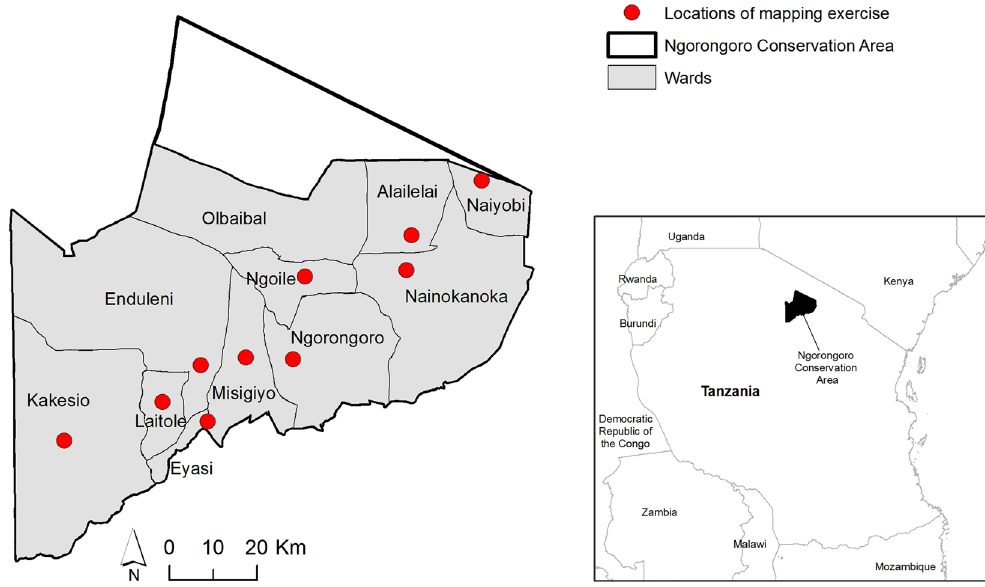
Figure 1. Locations of participatory mapping. Map showing the 11 administrative wards of the Ngorongoro Conservation Area in northern Tanzania and the locations where participatory mapping sessions took place (red dots). The maps were produced in QGIS 2.18.2 using data from the National Bureau of Statistics, Tanzania (http:// www. nbs. go.